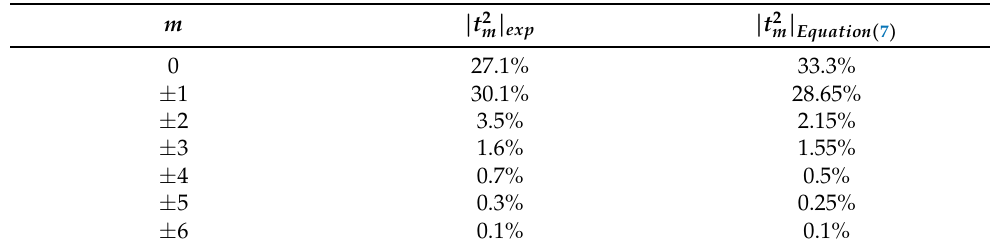
Table 2. Experimental and predicted diffraction efficiencies for λ 0 = 632.8 nm of the grating designed to be a three splitter.